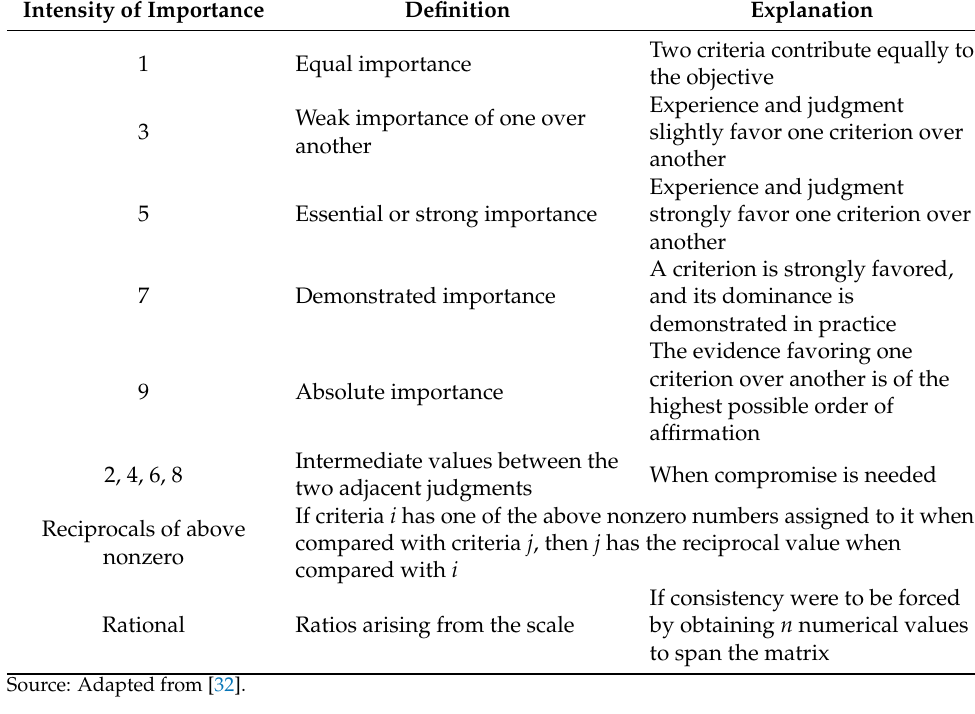
Table 1. Scales used in AHP comparison